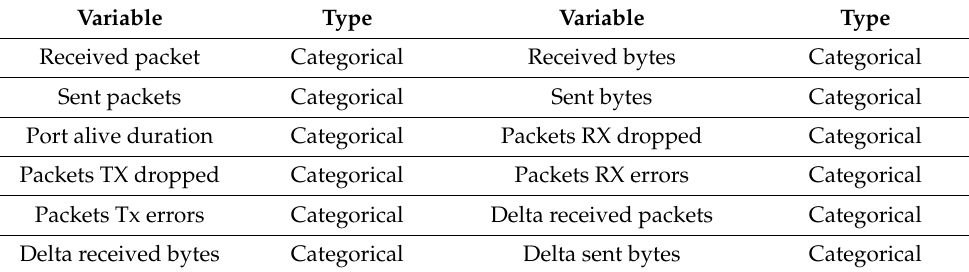
Table 2. Description of the dataset.